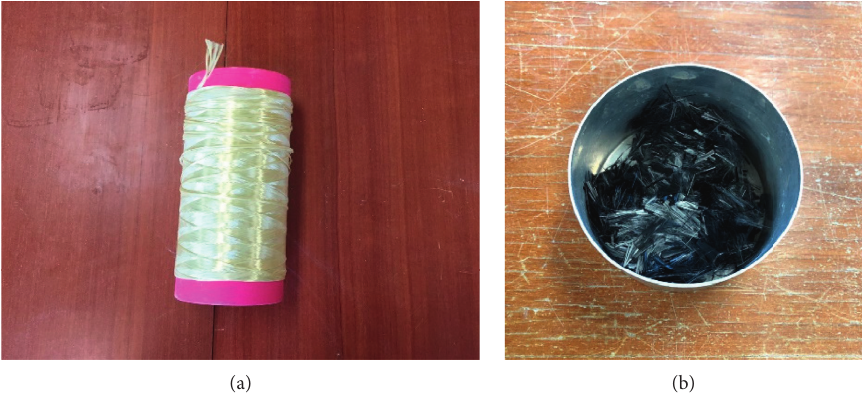
Figure 1: Experimental fiber: (a) aramid fiber; (b) carbon fiber.